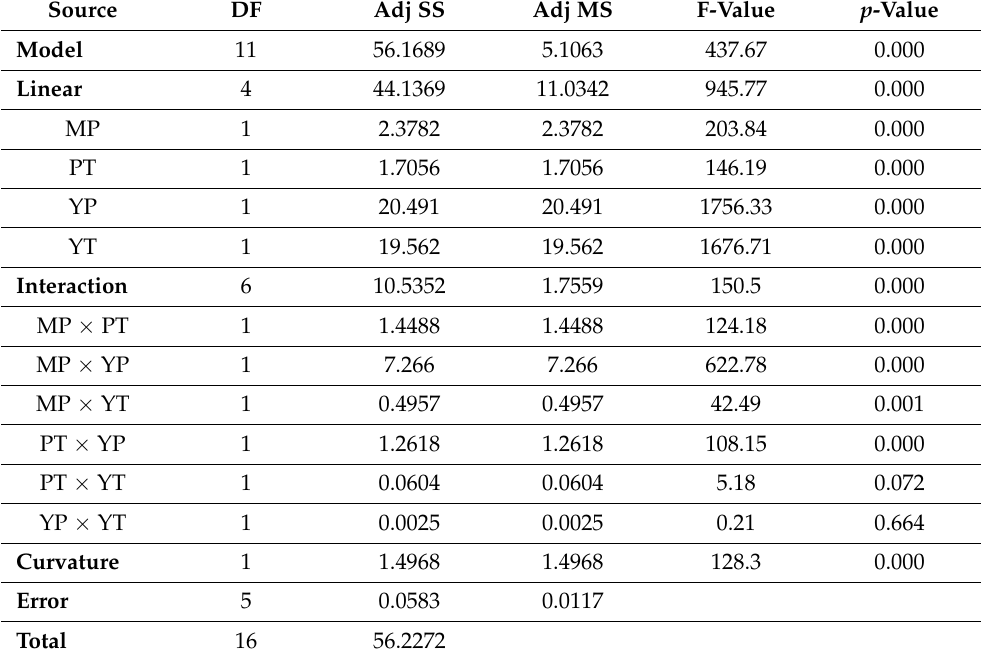
Table 4. Full factorial design ANOVA of vertical magnetization